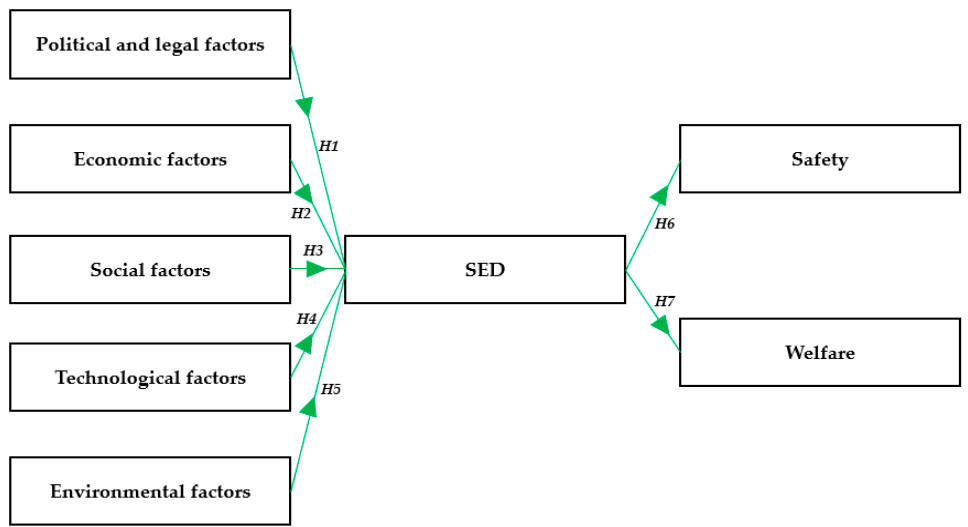
Figure 5. Graphical interpretation of the SED concept (Note that the return of the arrow indicates the direction of the “potential” relationship, while the green colour of the arrow indicates that the relationship will be positive). Source: own study.